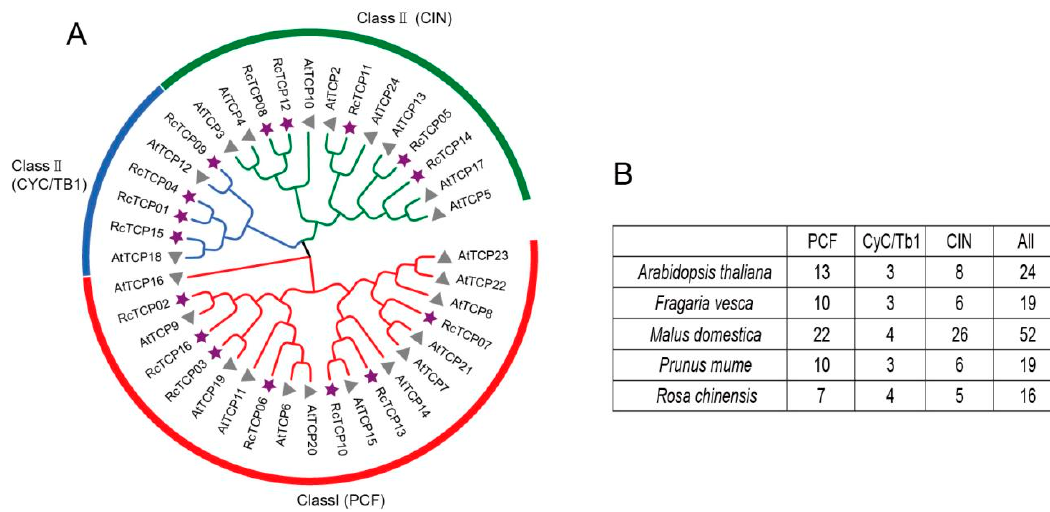
Figure 2. The phylogenetic tree of RcTCPs. ( A ) The phylogenetic tree of TCP proteins from R. chinensis and A. thaliana . ( B ) Number of each subclass of TCP genes in Rosaceae family and A. thaliana .